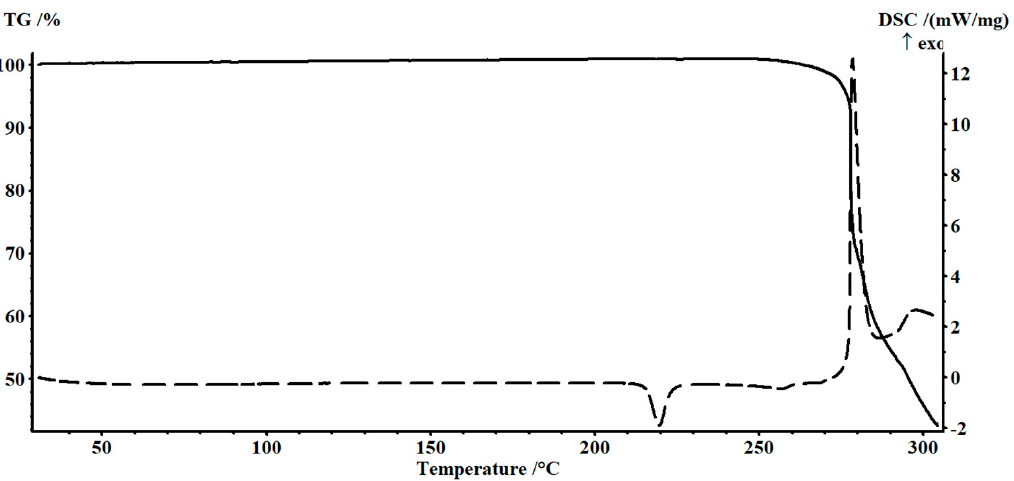
Figure 4. TG and DSC curves of (2,3,5-TPhTz) 2 [CuCl 4 ].